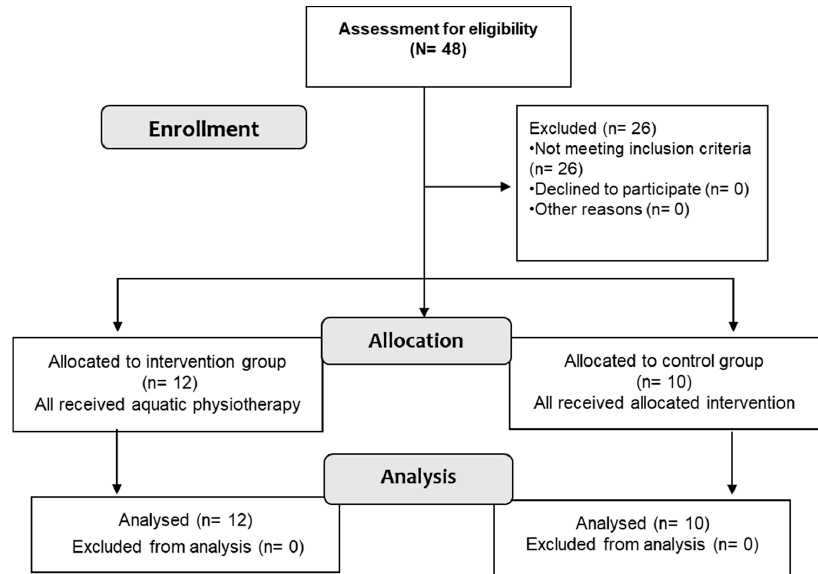
Figure 1. Study design (CONSORT 2010).